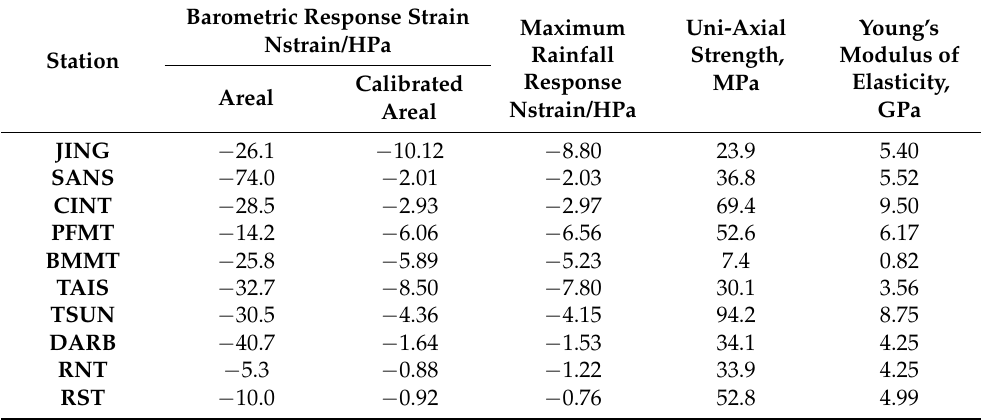
Figure 9. Comparison between the barometric responding strain and maximum rainfall responding strain, which are approximately in phase. Table 3. Barometric and maximum rainfall response of each channel of the borehole strainmeters (unit: